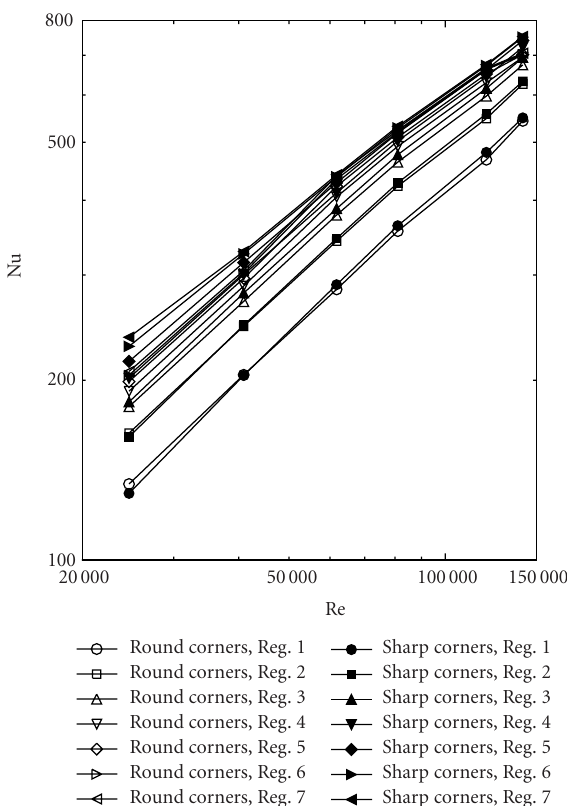
Figure 5: Comparison between the numerical results for sharp- and round-corner ribs with 10% blockage ratio ( e/D h = 0 . 1, P/e = 10).